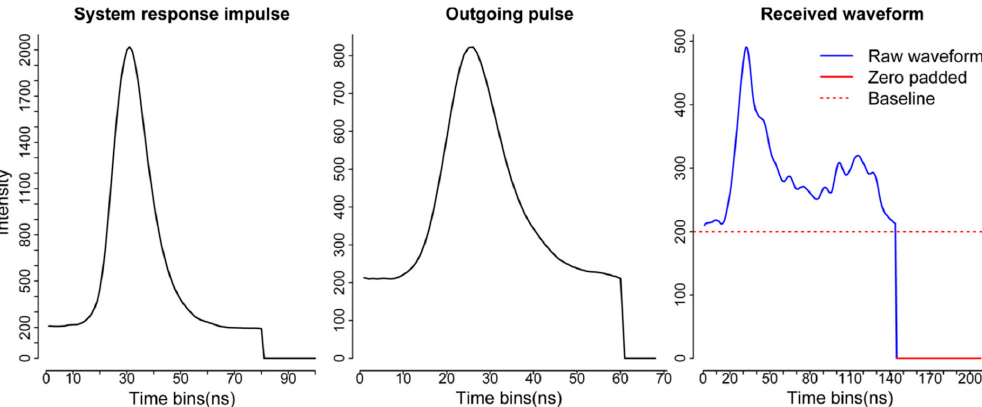
Figure 3. A subset of the system response impulse, a sample of outgoing pulse and corresponding raw waveform recorded by National Ecological Observatory Network’s (NEON) full waveform LiDAR system [6].